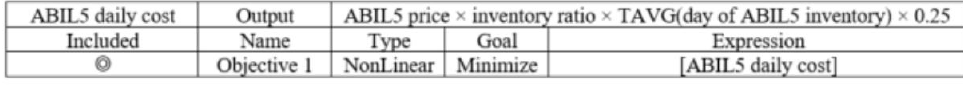
Figure 10. Setting values of the minimal objective function for drug ABIL5.